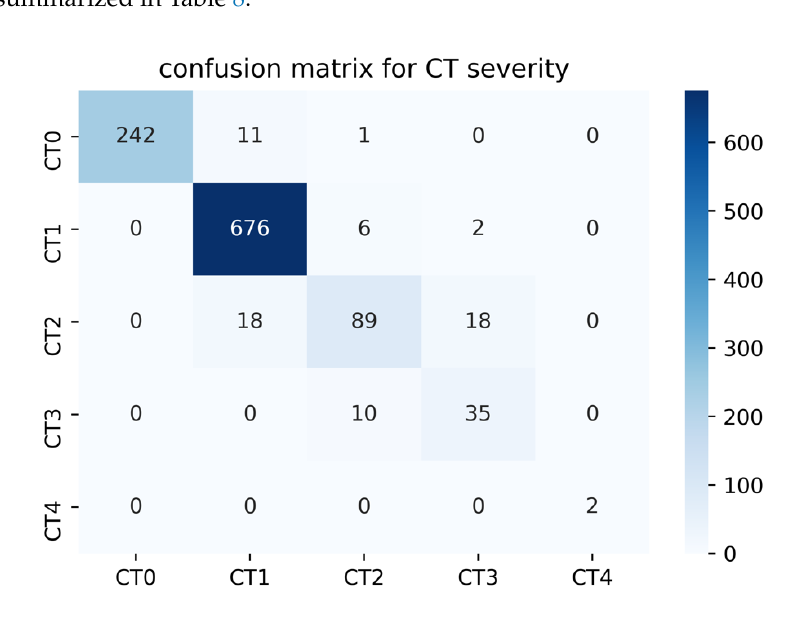
Figure 8. Confusion matrix for CT severity classification of the CT volumes of MosMedData Dataset. Table 8. Performance matrices for severity